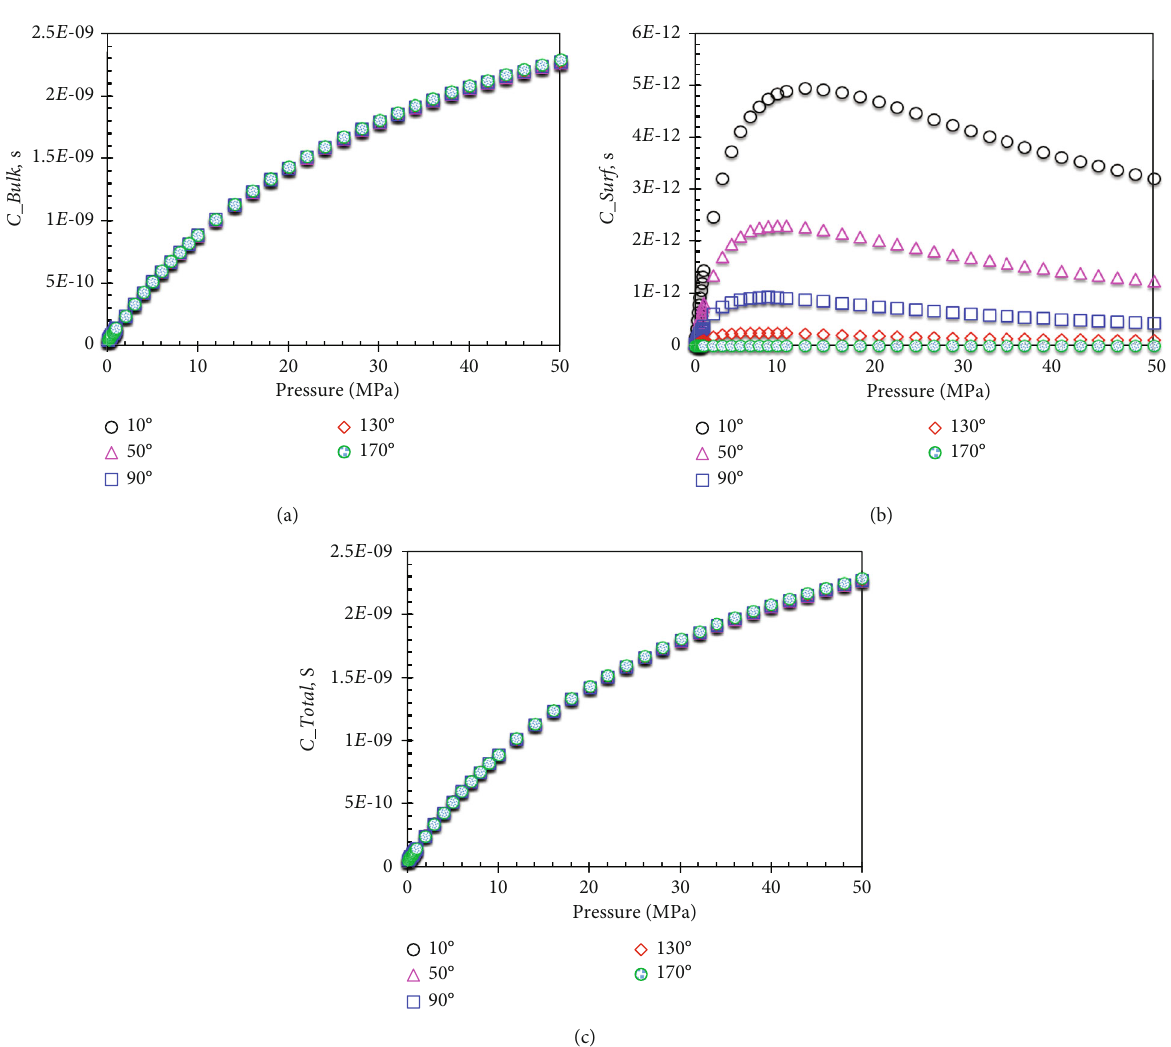
Figure 11: Wettability impact on gas transport through organic nanopore when pore size is equal to 50 nm: (a) Bulk-like gas conductance; (b) Surface di ff usion; (c) Total gas